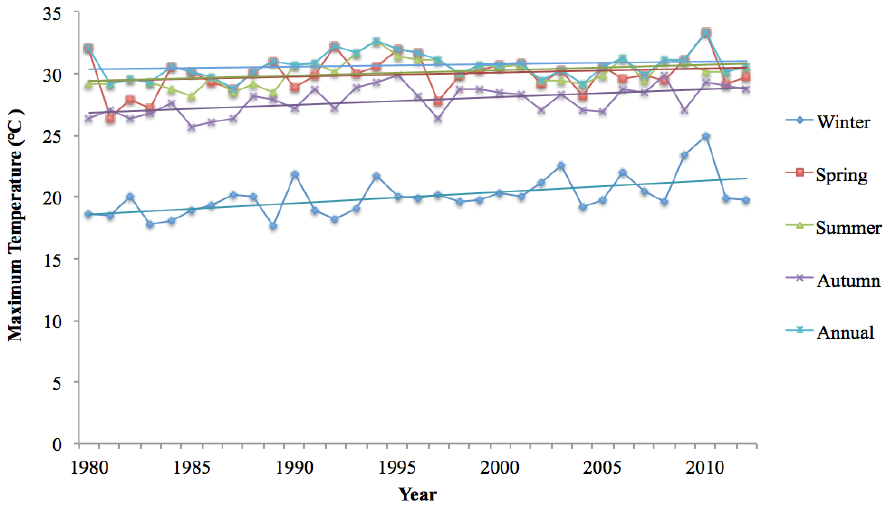
Figure 4. Seasonal and annual maximum temperature trends at the Khudi station from 1980 to 2012.